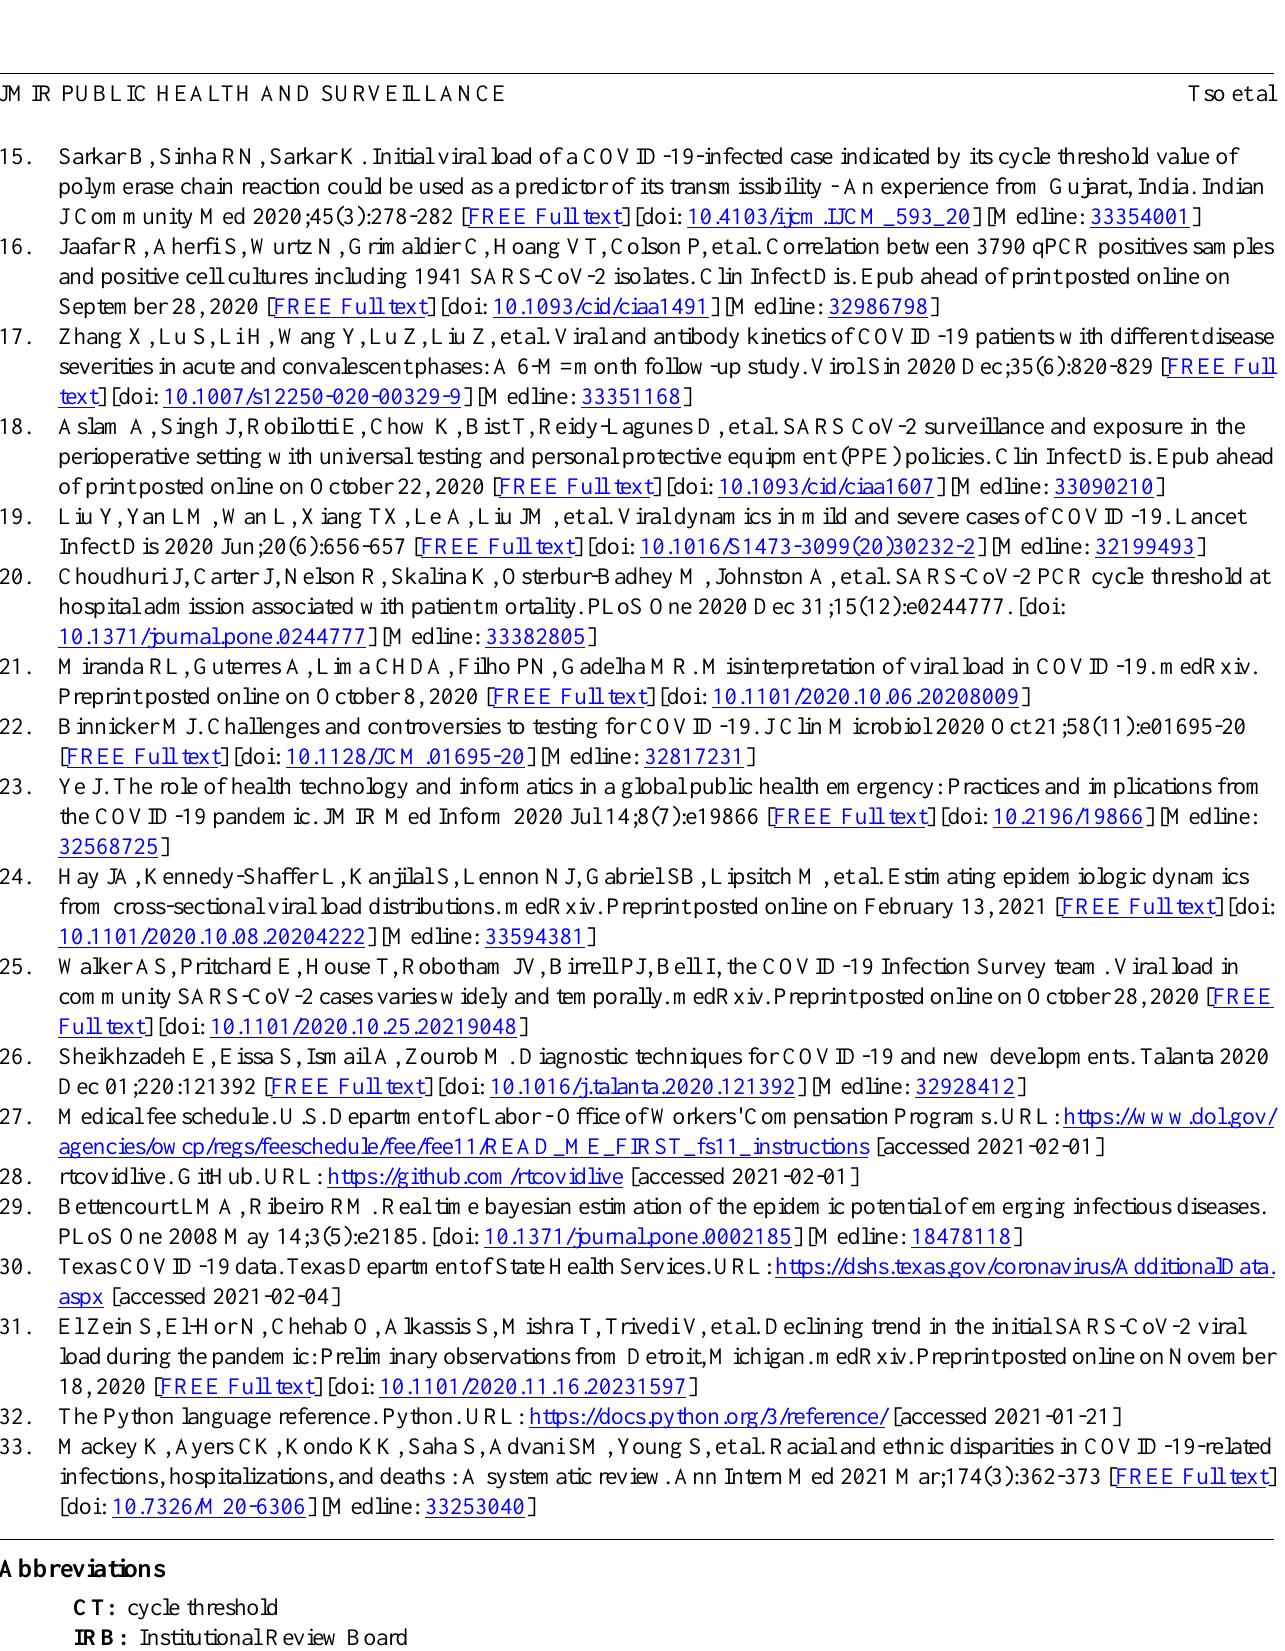
R : transmission rate t RT-PCR: reverse transcription polymerase chain